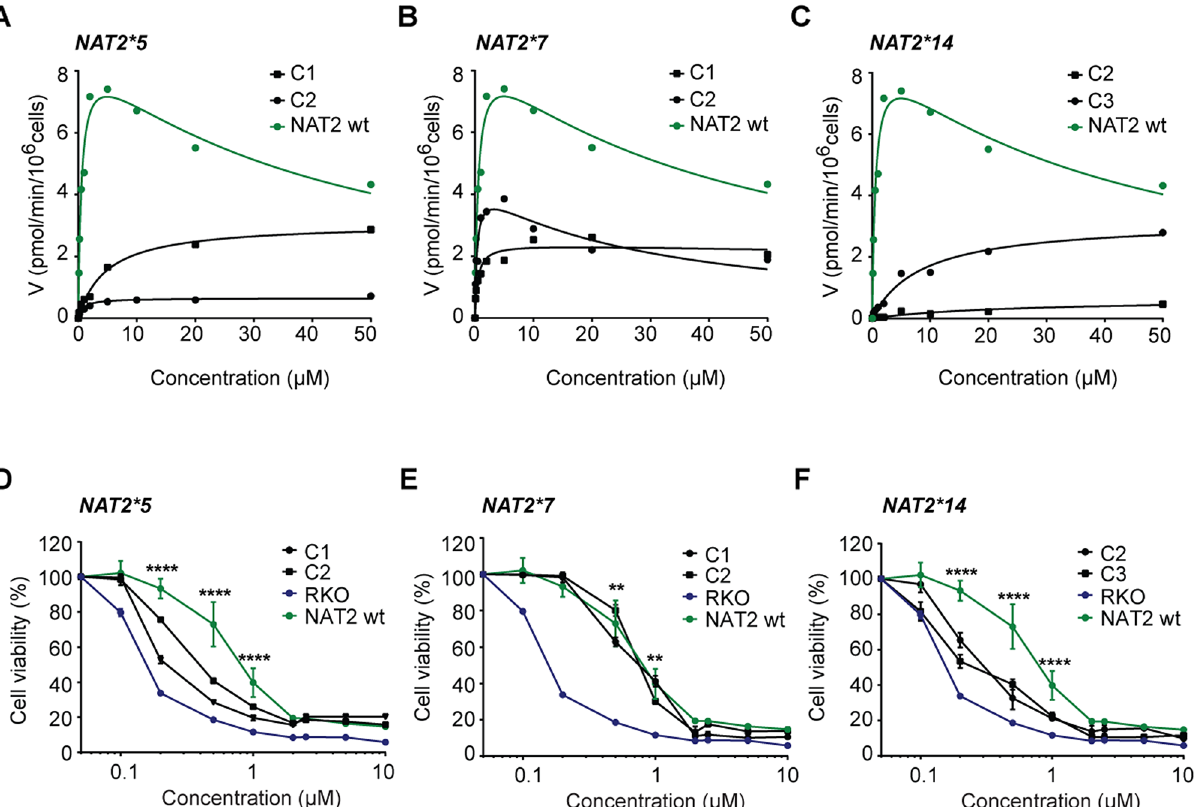
Figure 4. Colorectal cancer cells expressing NAT2_5 and NAT2_14 but not NAT2_7 are sensitive to APA treatment. ( A – C ) Quantification of NAT2 catalytic activity in RKO clones expressing ( A ) NAT2_5, ( B ) NAT2_7 and ( C ) NAT2_14 enzymatic variants. The velocity at which APA becomes acetylated was measured by LC– MS/MS at different concentrations. A representative experiment is shown for each enzymatic variant. ( D – F ) Dose response for APA in RKO clones expressing the ( D ) NAT2_5, ( E ) NAT2_7 and ( F ) NAT2_14 enzymatic variants. Cell viability was measured by a MTT assay after 72 h. The mean and S.D. of three